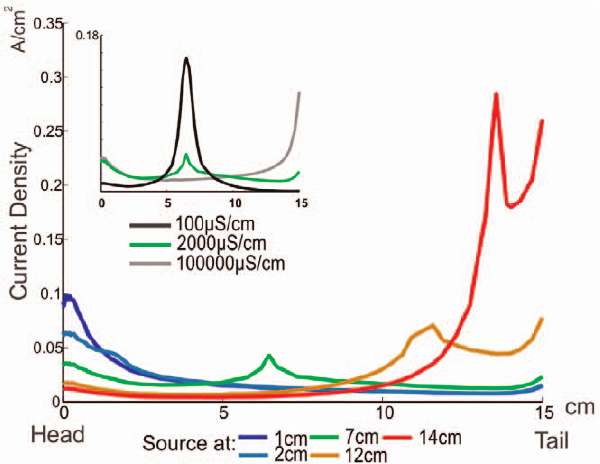
Figure 3. MoGO calculated transepithelial current density along a line on a horizontal plane. Different positions (color coded) of equivalent, unitary, sources are compared. The inset compares how spread of transcutaneous current density depends on body conductance. The source is placed at mid-body (7 cm from the head). Medium conductance was set at 100 m S/cm.